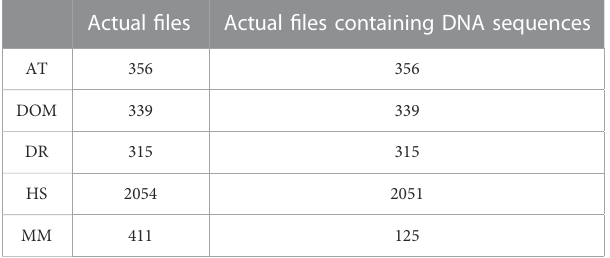
TABLE 5 Demonstration of actual fi les containing gene sequences corresponding to AT, DOM, DR, HS, and MM species. Actual fi